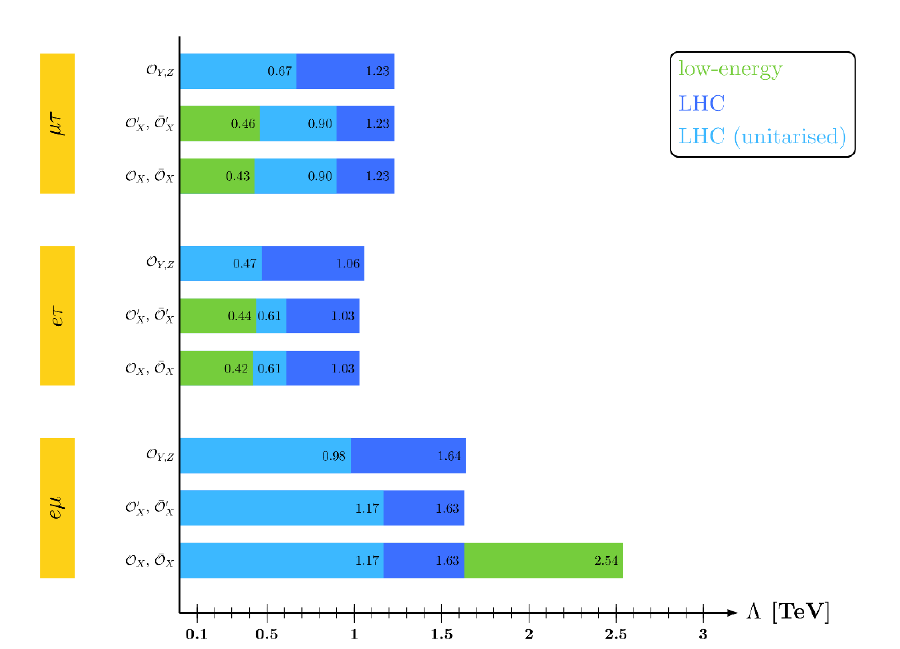
Figure 6 . Summary of all constraints on the scale of the dimension-8 operators with two gluon (cid:12)eld strength tensors and two leptons. Green indicates the most stringent low-energy constraint and limits obtained from the LHC study are shown in blue: dark blue for ordinary EFT and light blue for the unitarised EFT. The exact numerical value for each constraint is given at the end of each bar in